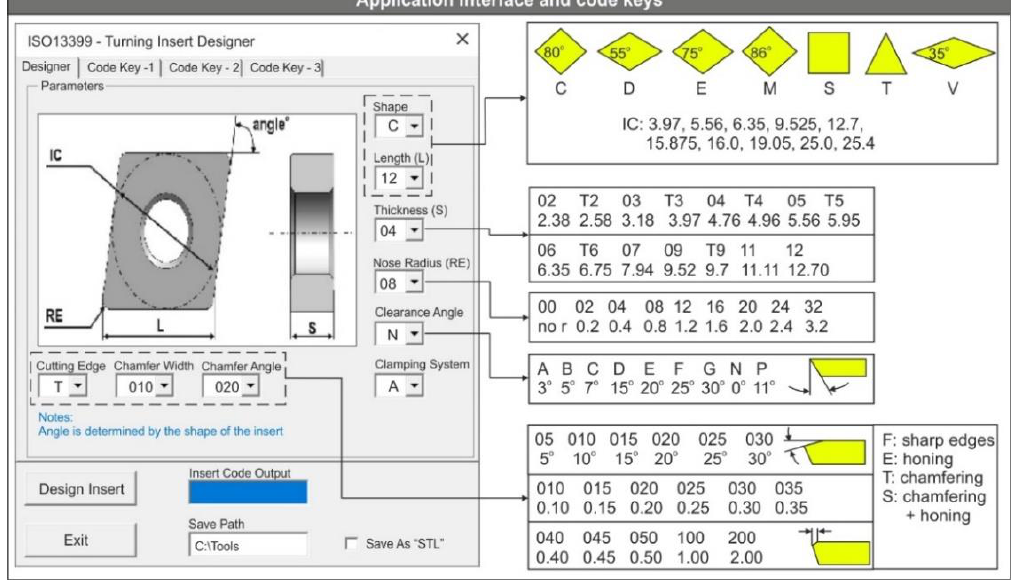
Figure 3. The application’s interface and the corresponding code keys.